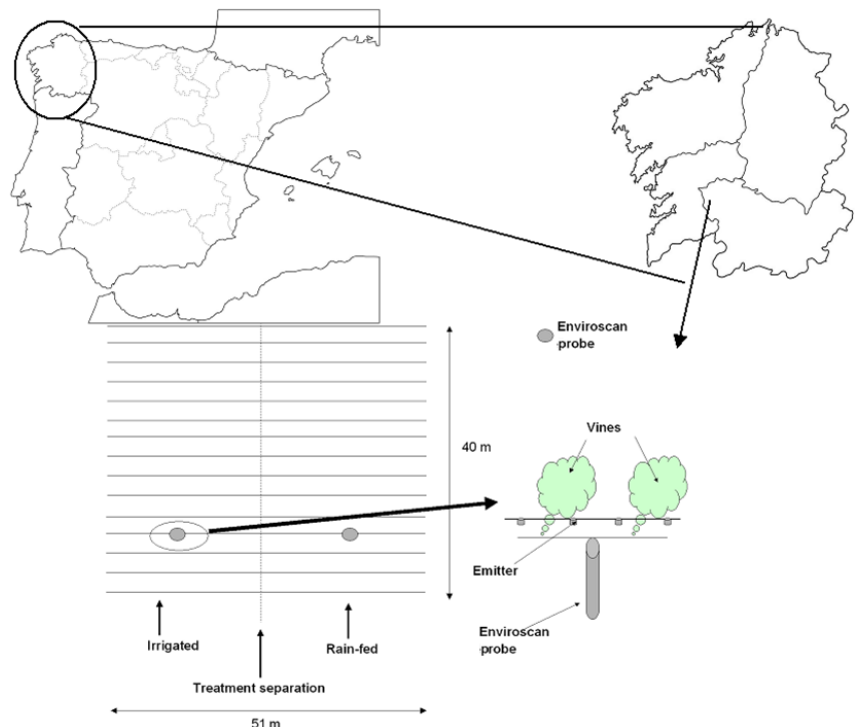
Figure 1. Location of the studied vineyard and experimental